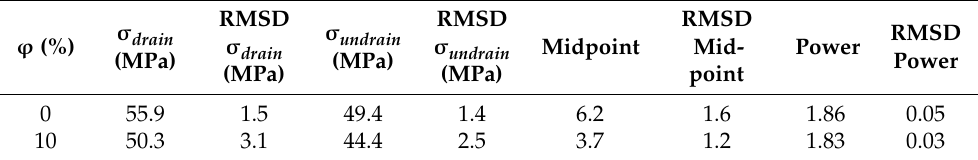
Table 4. Parameters of the logistic dependence of the uniaxial compressive strength of high-strength concrete with a two-scale porosity (6 vol.% of capillary pores and 4 vol.% of micropores) on the generalized loading rate parameter Da